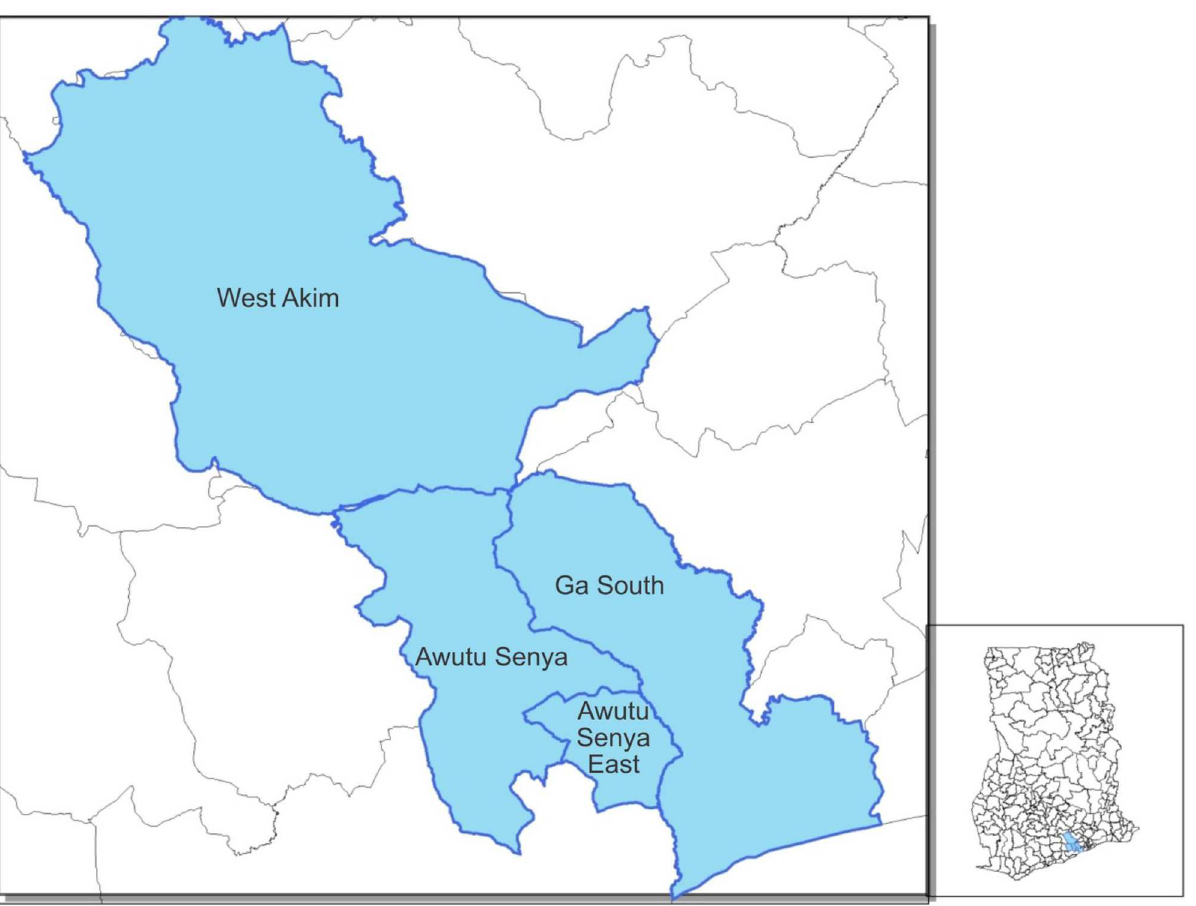
Fig 1. Study Districts Ga South, Awutu Senya and West Akim Districts of Ghana. In 2012 the Awutu Senya district was dividedinto Awutu Senya and Awutu Senya East